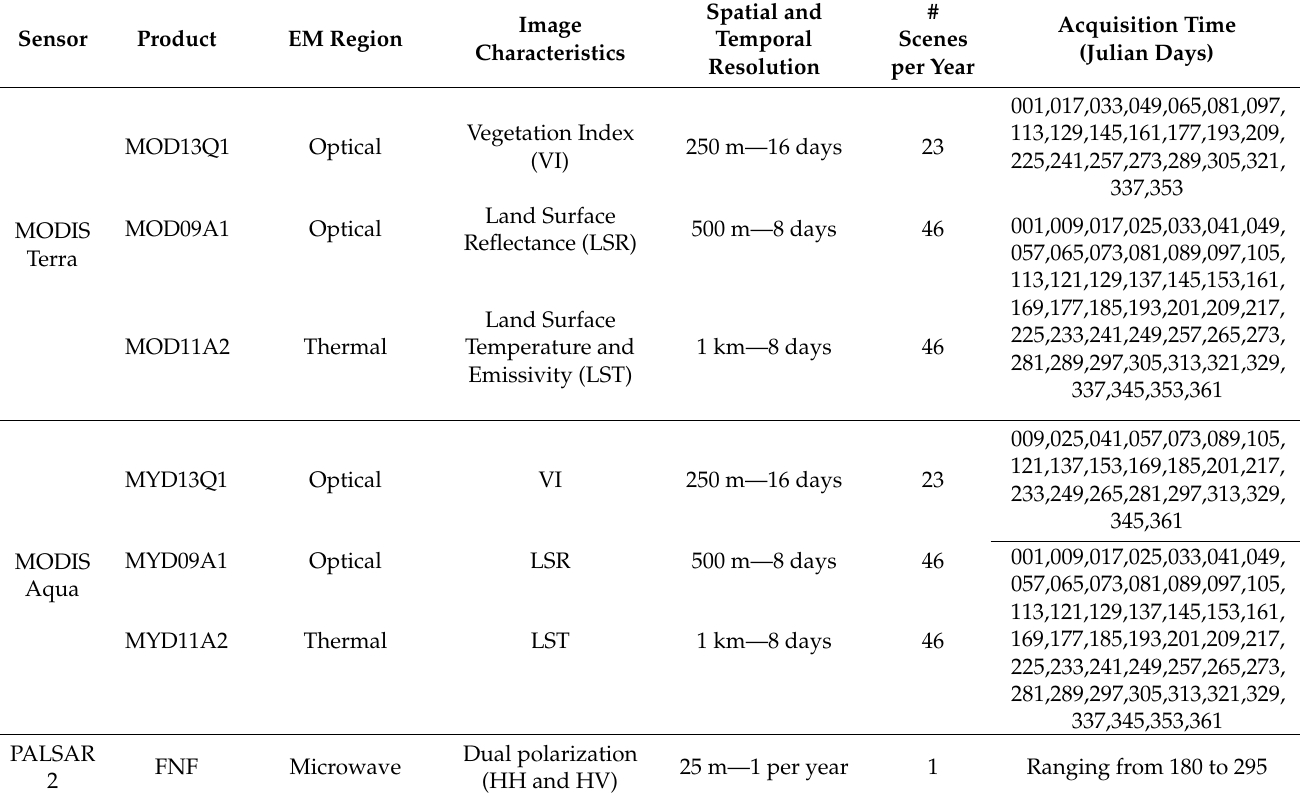
Table 1. List of the satellite imagery and products used in this